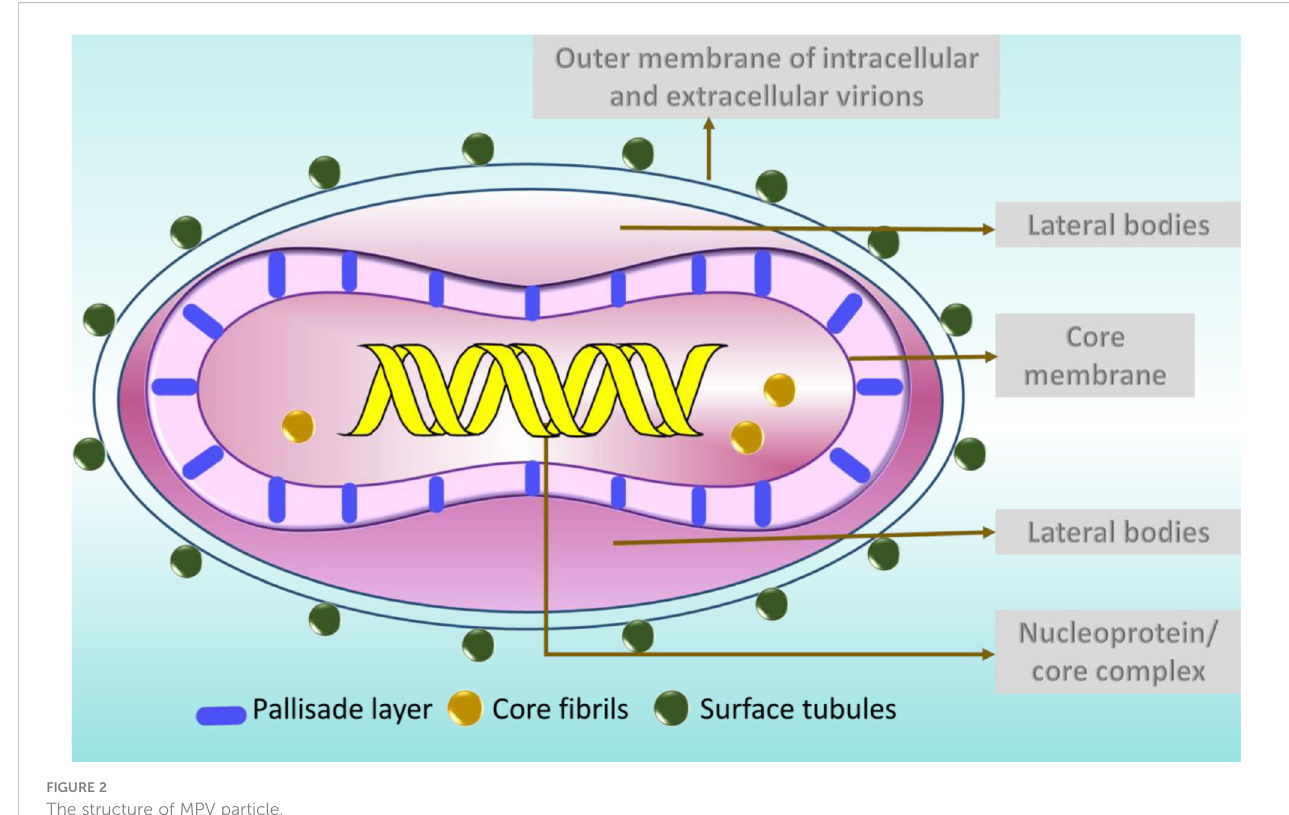
FIGURE 2 The structure of MPV